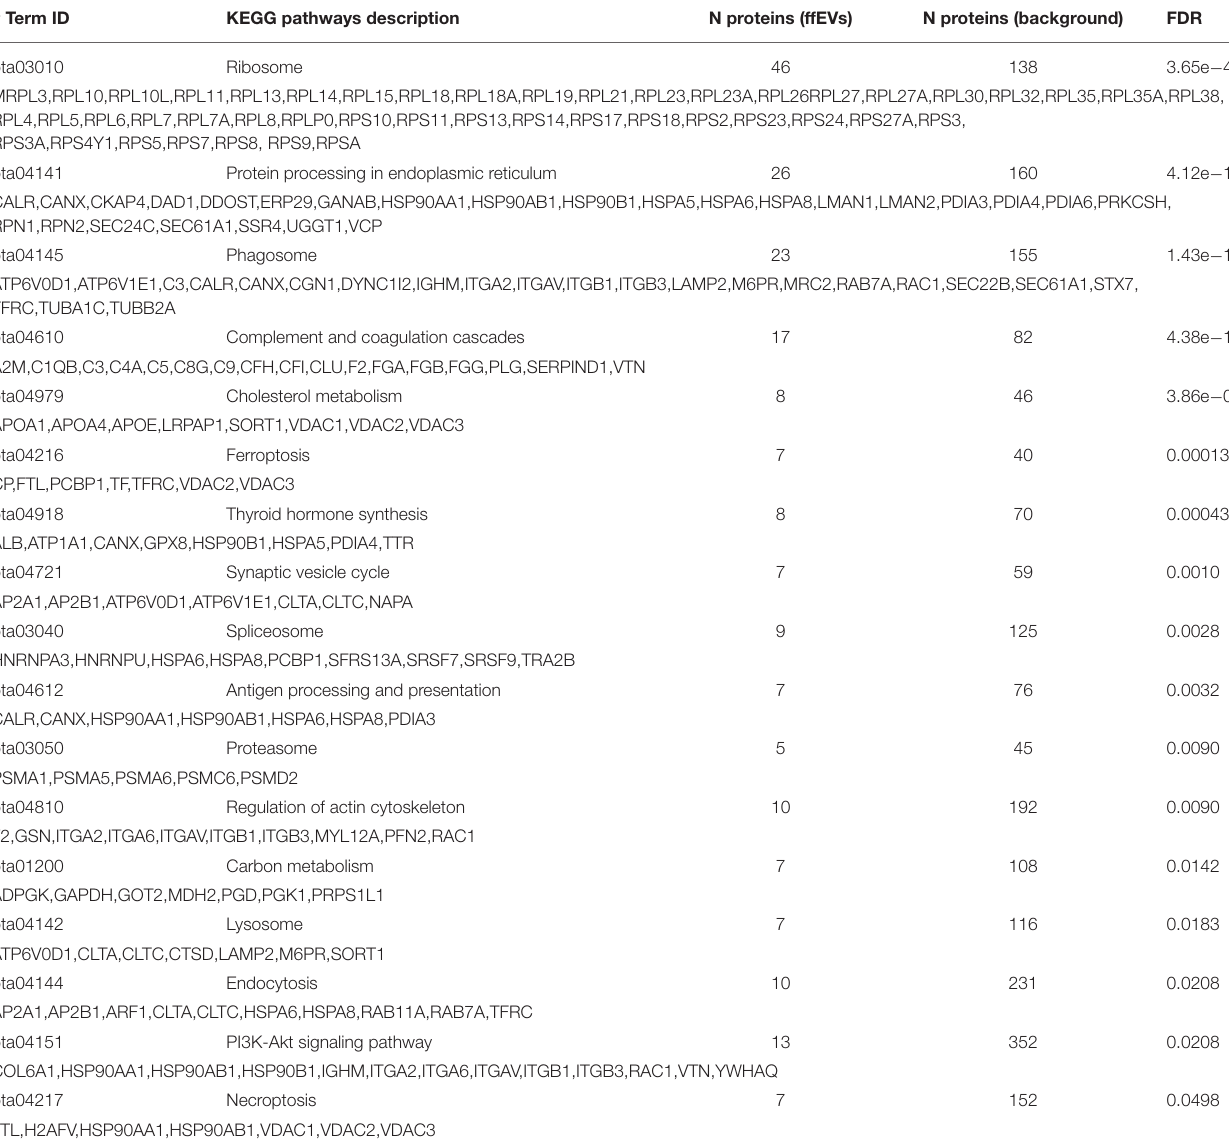
TABLE 3 | Biological pathway enrichment in bovine ffEV proteins via the analysis of functional protein association networks. # Term ID KEGG pathways